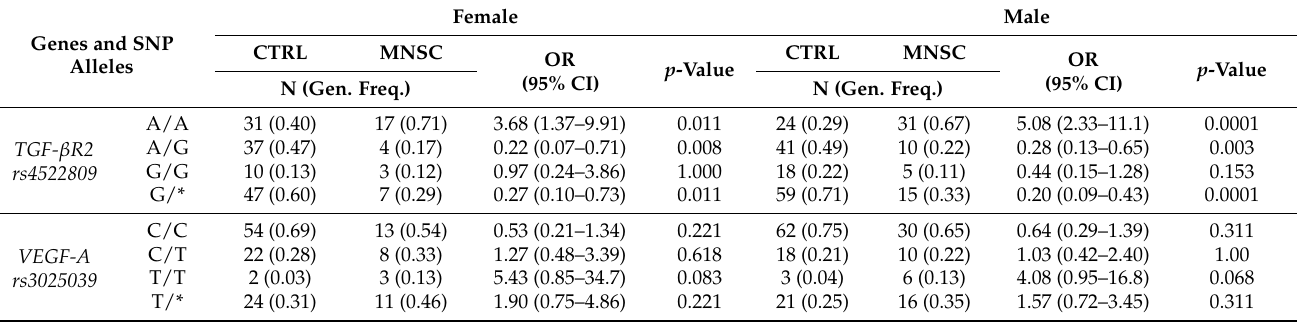
Table 5. Significantly different SNP frequencies in non melanocitic skin cancer patients (NMSC) and controls (CTRL), stratified according to gender (adjusted by age cut